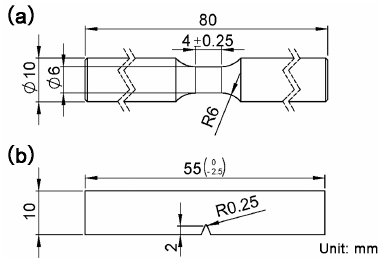
Figure 5. Dimensions of tensile and impact specimens of the repeated welding specimens: ( a ) tensile specimen; and ( b ) Charpy-V impact specimen.